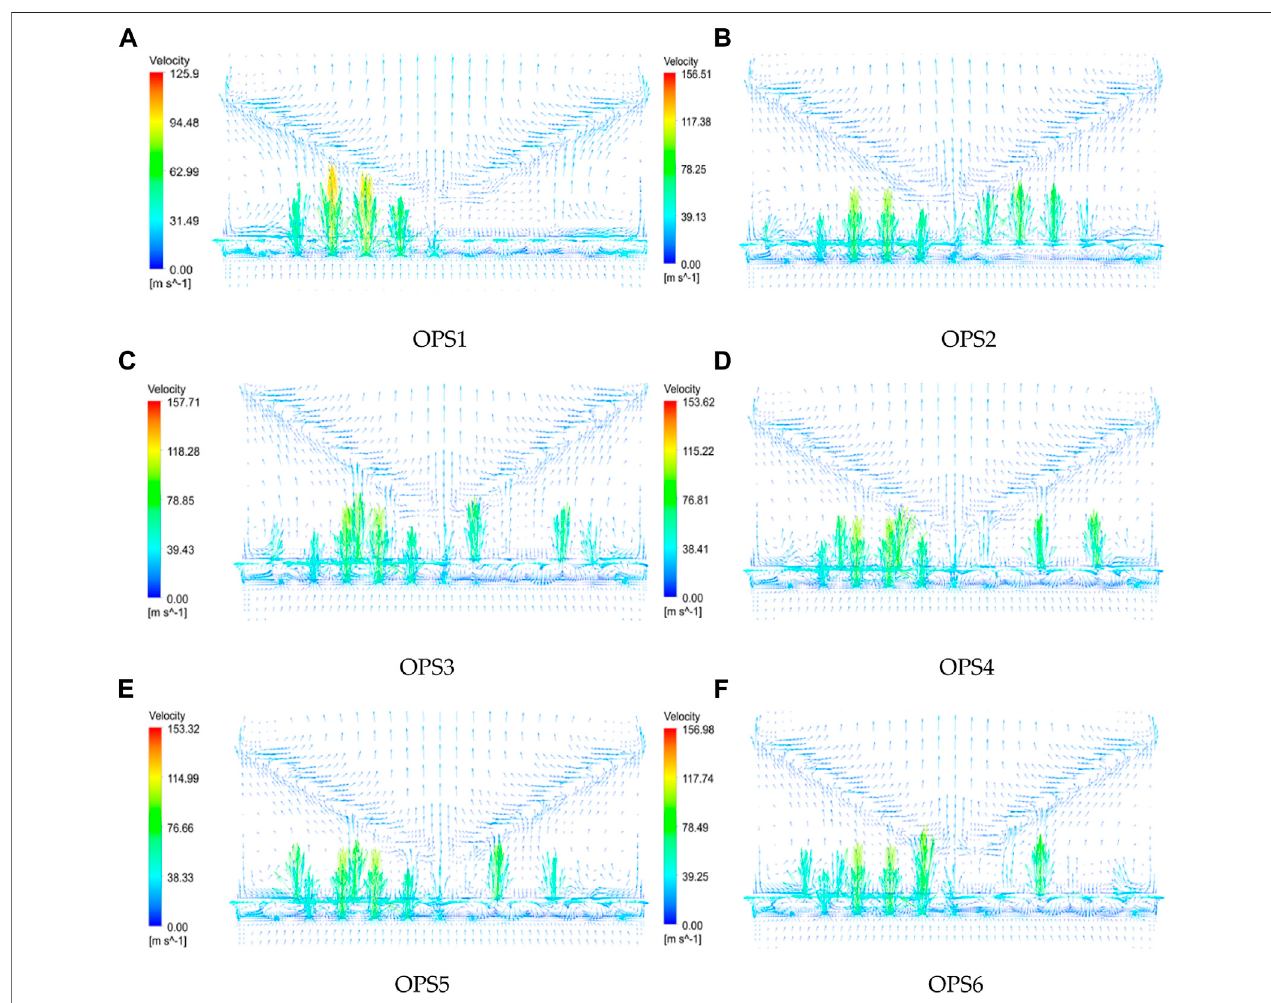
FIGURE 8 | In fl uence of the air homogenizer on the mainstream fi eld.